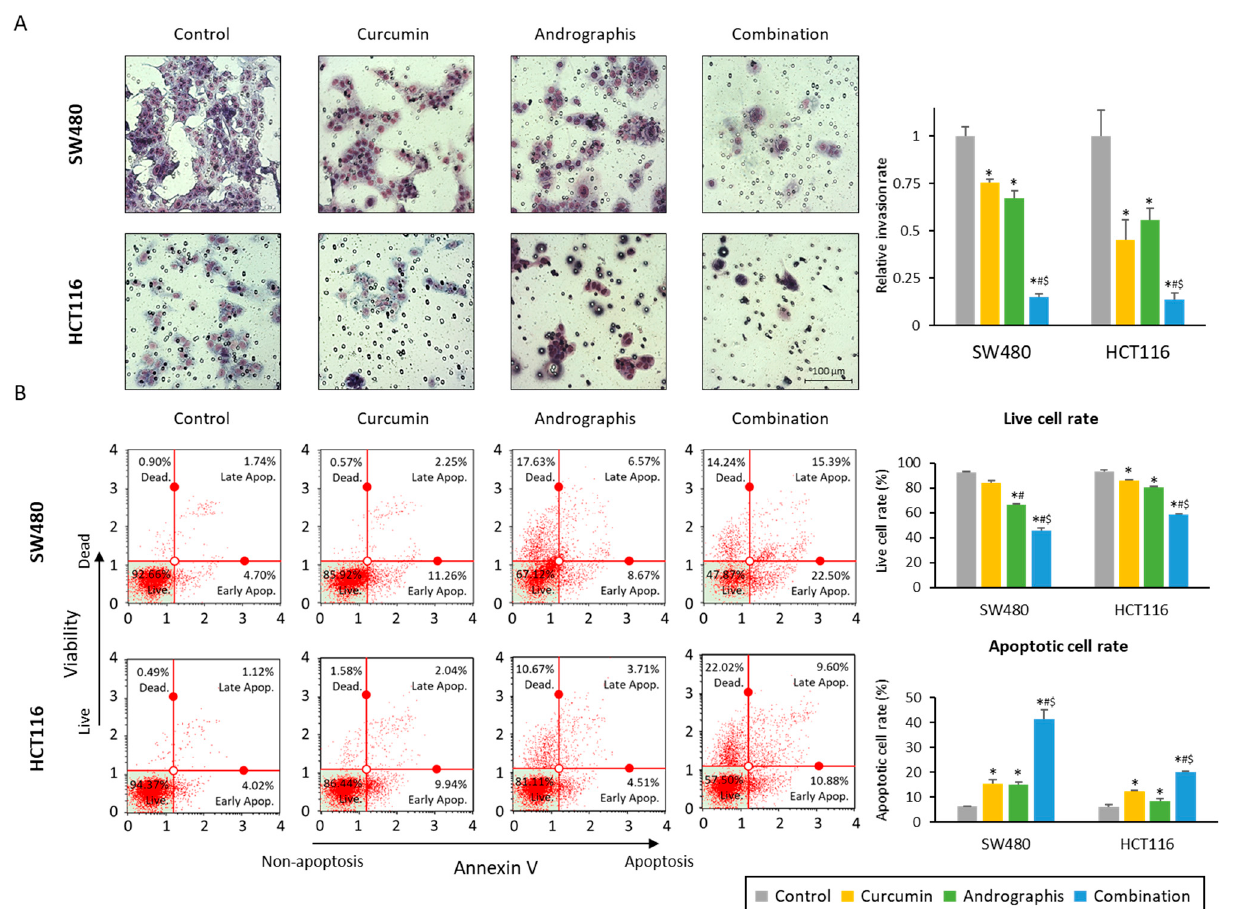
Figure 2. Curcumin and andrographis combination treatment revealed anti-tumor effects via reduc- tion of invasion and induction of apoptosis. ( A ) Invasion assay following treatment with curcumin, andrographis, and their combination for 48 h in SW480 and HCT116. Scale bar = 100 µ m. The number of invading cells was counted randomly at three fields on the membrane, and relative invasion ratios were calculated. The average (column) ± SD is indicated (*; p -value < 0.05 vs. control, #; p -value < 0.05 vs. curcumin, $; p -value < 0.05 vs. andrographis). ( B ) Representative images of cells undergoing apoptosis that stained for the annexin V assay in SW480 and HCT116. The average (col- umn) ± SD is indicated (*; p -value < 0.05 vs. control, #; p -value < 0.05 vs. curcumin, $; p -value < 0.05 vs. andrographis). Cur: curcumin; andro: